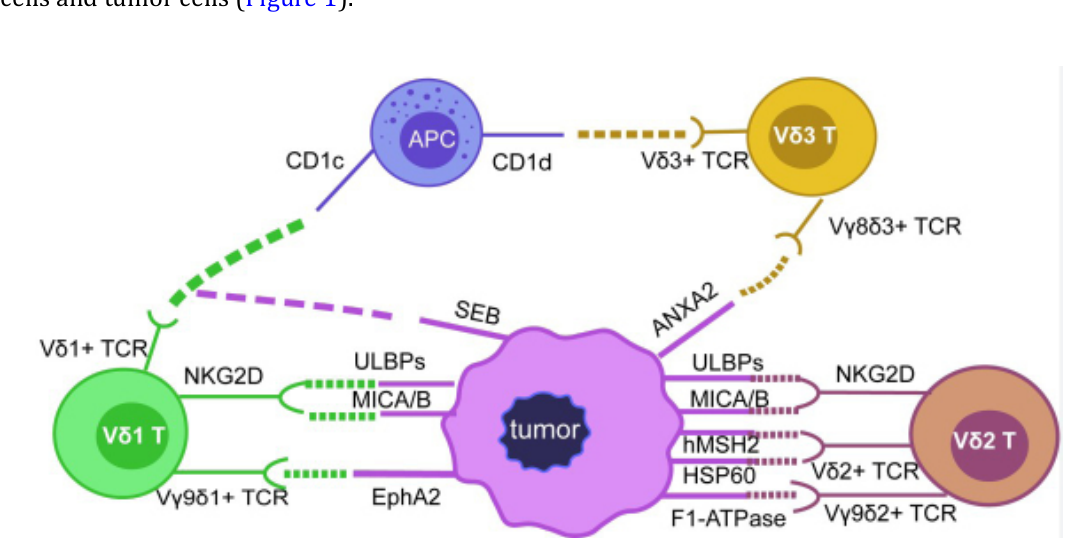
Figure 1. Protein ligands involved in mediating cancer cell recognition via γδ TCR. The diversity of γδ T cells is mainly determined by the diversity of γδ TCR. Vδ1 T cells can recognize CD1c, EphA2 protein ligands through Vδ1 + TCR and can be activated by SEB, and they can recognize ULBPs or MICA/B proteins through NKG2D receptors; Vδ2 T cells can recognize ULBPs and MICA/B through NKG2D, Vδ2 + TCR can also recognize and bind hMSH2, HSP60, F1-ATPase and ANAX2 proteins to activate Vγ9δ2 T cells; there are not many studies reported about the ligands recognized by Vδ3 T, but Vδ3 + TCR can recognize CD1d and ANXA2 protein